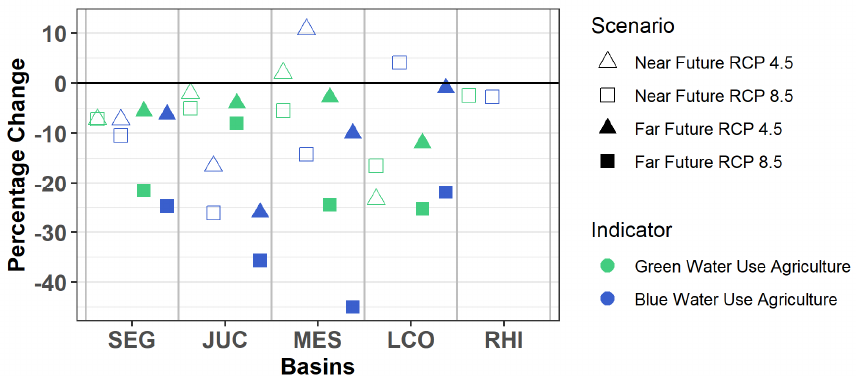
Figure 3. Percentage change of ( green ) green water use for rainfed and irrigated agriculture and ( blue ) blue water use for irrigated agriculture for the five river basins under the climate change scenarios.